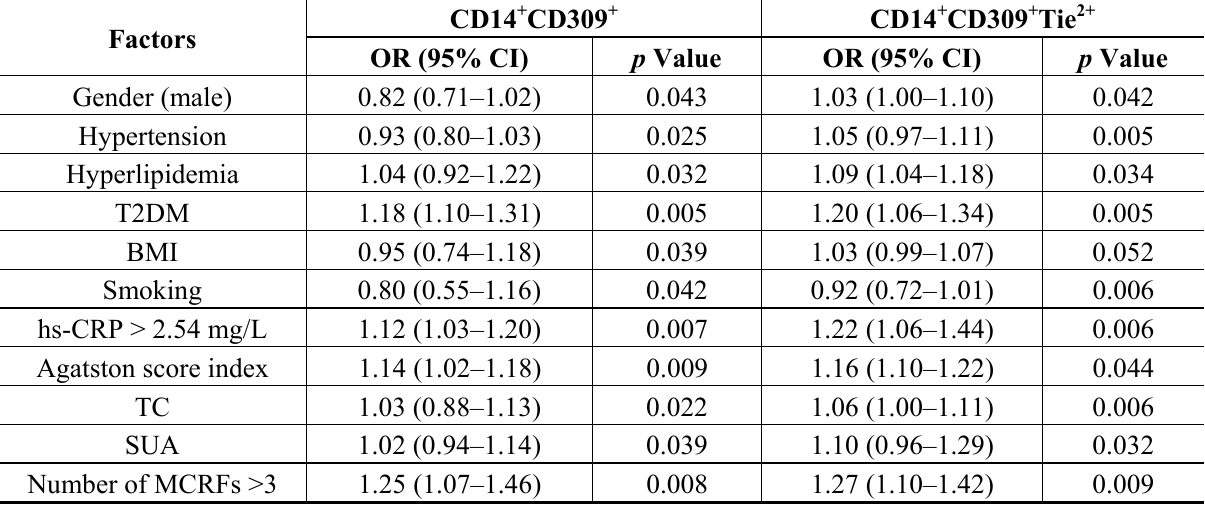
Table 4. Independent predictors of circulating circulating mononuclear cells (CMCs). The results of multivariate one-step backward logistic regression